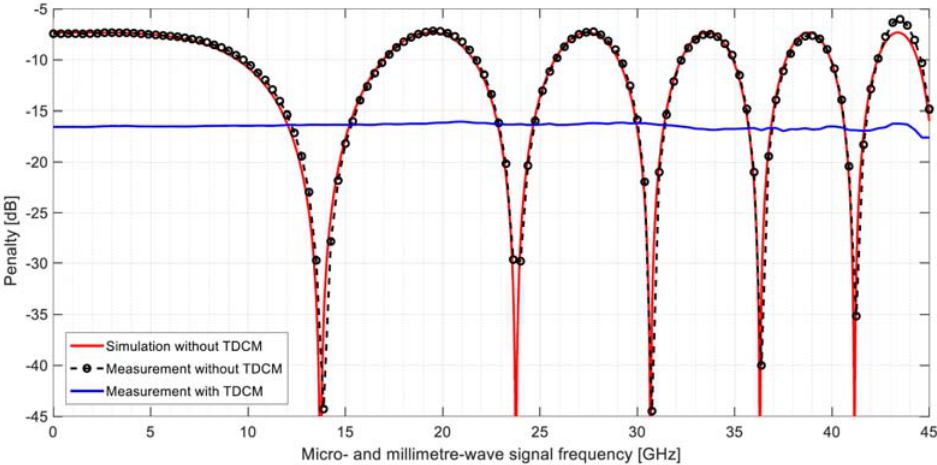
Figure 12. Power-penalty measurements from 10 MHz to 45 GHz over a 20-km optical fiber. Reprinted from Reference [93].